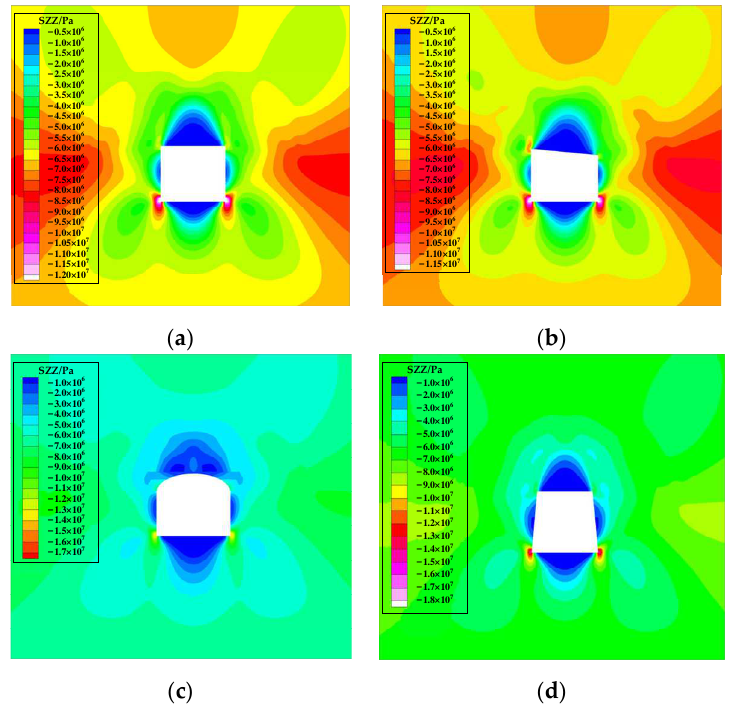
Figure 10. Vertical stress distribution characteristics of the surrounding rock in different channel section forms: ( a ) rectangle; ( b ) slanted-top rectangle; ( c ) straight-walled circular arch; ( d ) trapezoid.